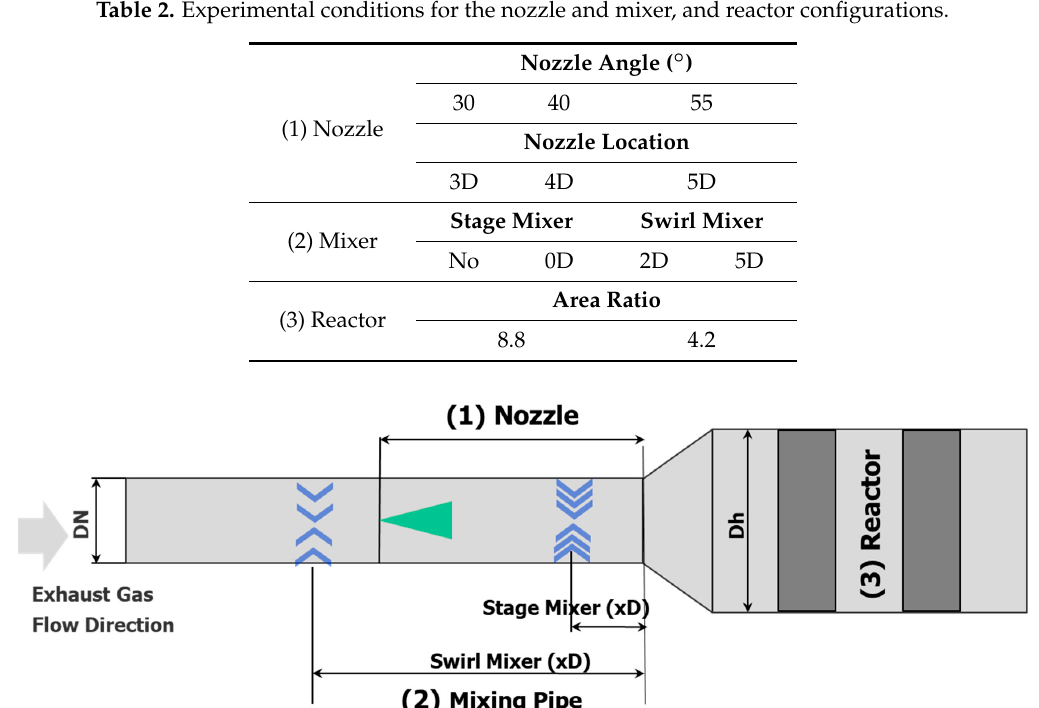
Table 2. Experimental conditions for the nozzle and mixer, and reactor configurations.